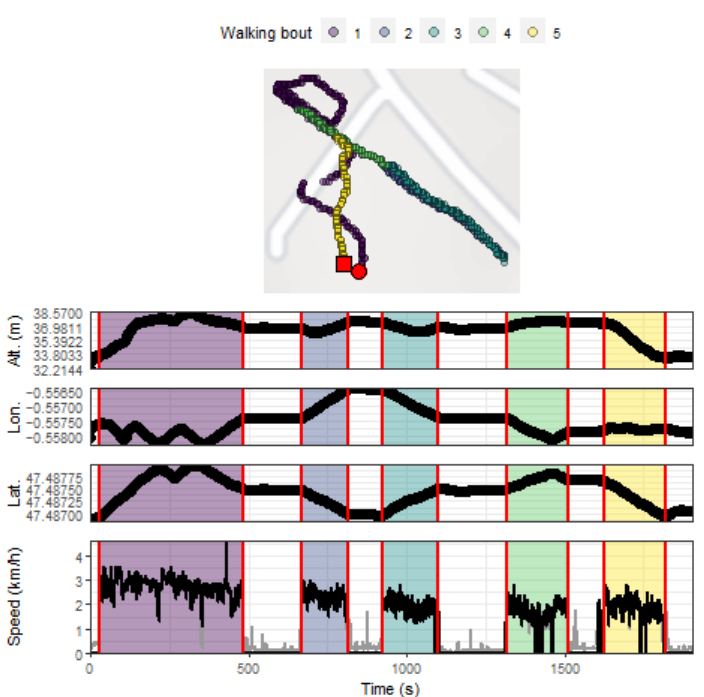
Figure 3. Example of GPS data obtained during an outdoor walking session (Participant #1). The upper panel depicts the positions recorded during the session, with the red circle and square indicating the beginning and the end of the session, respectively. The colored zones in the middle and lower panels highlight the walking bouts detected using the implemented speed processing methodology [13]. The altitude values are those from the French National Institute of Geography map projections that corresponded to the latitude and longitude data recorded by the GPS device. Grey lines depict raw speed values obtained with the GPS device and that were transformed following the speed data processing procedure. Lat. = latitude; Lon = longitude; Alt. =